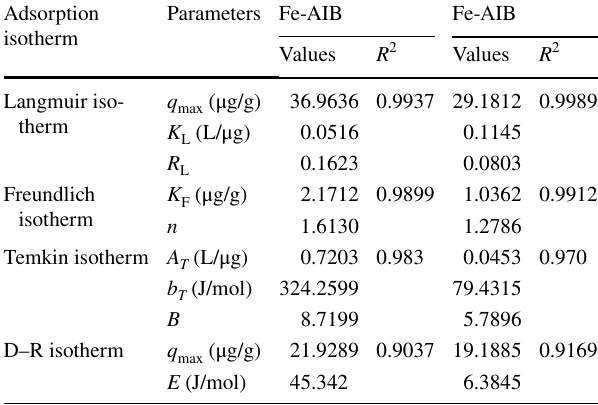
Table 6 Isotherm data for adsorption of arsenate by Fe-AIB and Fe- AIL Adsorption